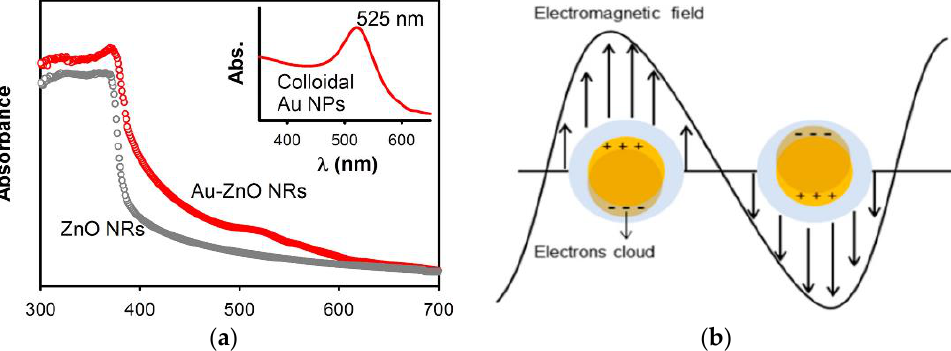
Figure 6. ( a ) UV/visible optical absorption spectra of pure ZnO nanorods (NRs) and AuNPs-doped ZnO NRs. Inset shows the UV/Vis spectrum of colloidal AuNPs (~20 nm) with a plasmon absorption peak at 525 nm. Reproduced from [61] with permission of Nature under the Creative Commons Attribution license. ( b ) Schematic illustration of oscillation of free electrons of noble metal NPs with electric field of incident light. Reproduced from [68] under the Creative Commons Attribution license.